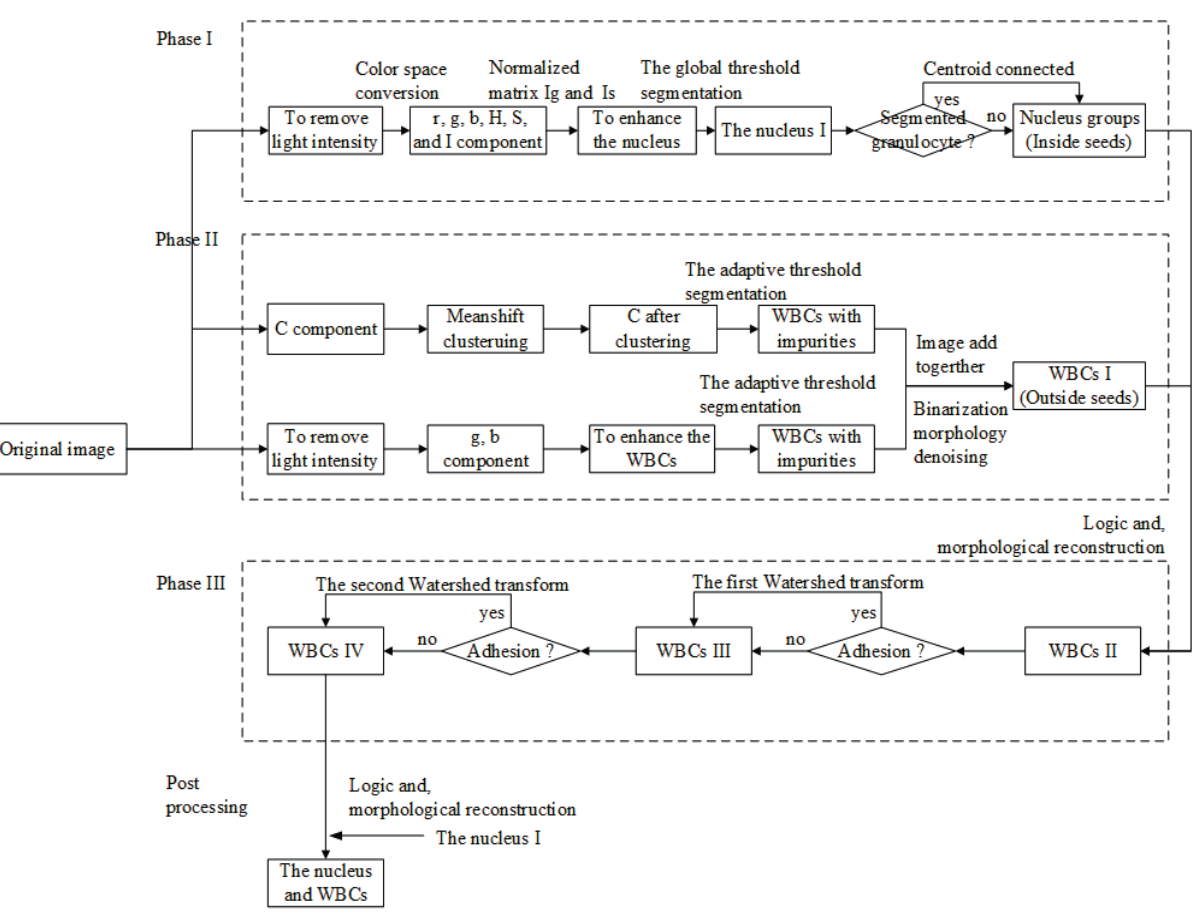
Figure 2. Framework of WBC